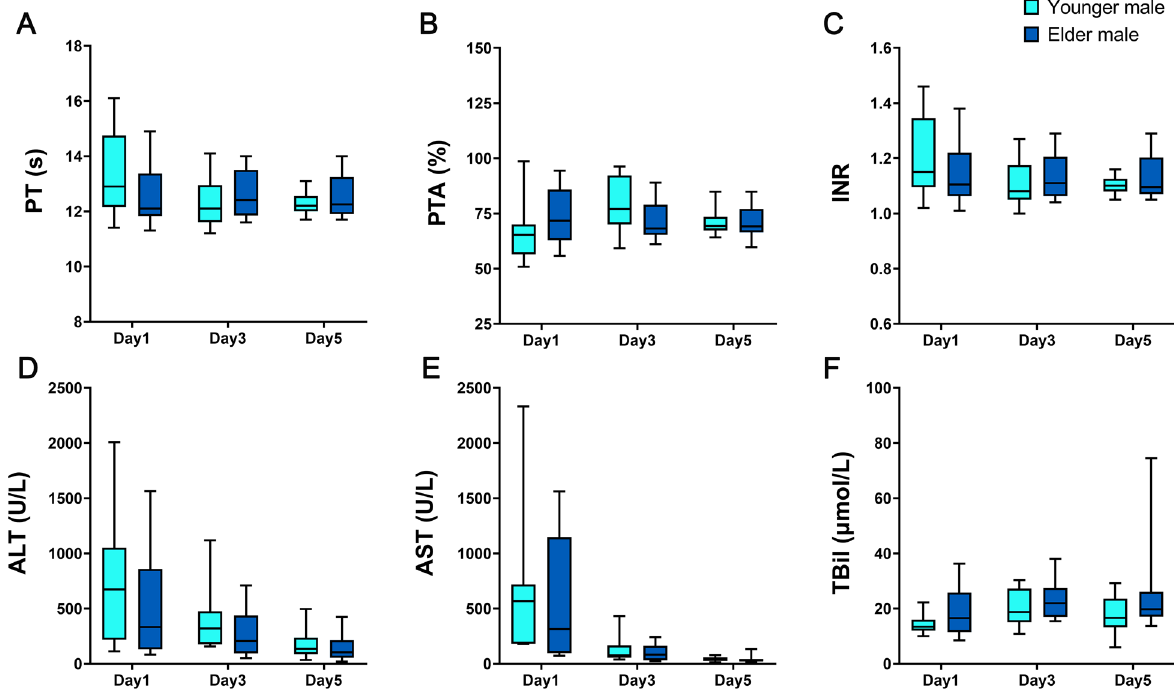
Figure 4. Comparison of coagulation function and liver function between younger male group and elder male group. ( A ) PT, ( B ) PTA, ( C ) INR, ( D ) ALT, ( E ) AST, ( F ) TBil (* P < 0.05, ** P < 0.01, *** P < 0.001).